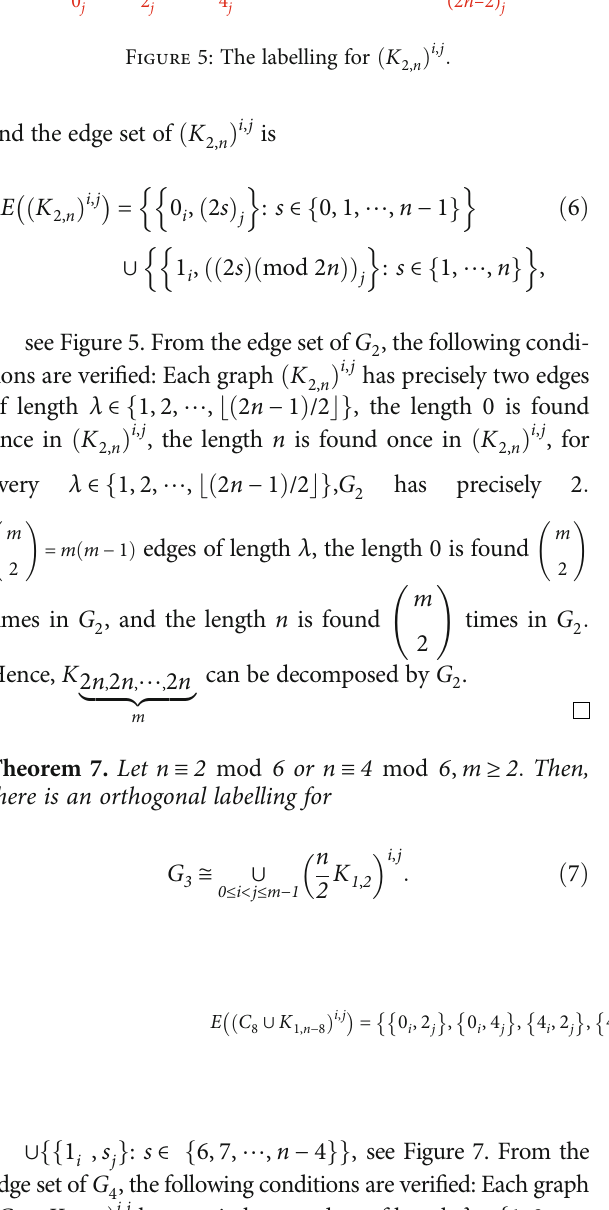
Figure 5: The labelling for ð K